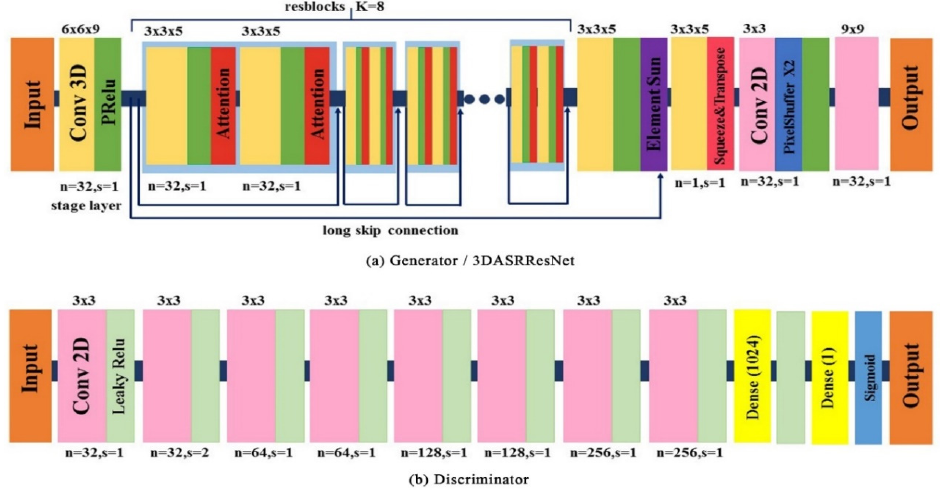
Figure 1. The architecture of generator ( a ) and discriminator ( b ) networks with the corresponding number of ResNet blocks (K), number of feature maps (n), and stride (s) are indicated for each convolutional layer.